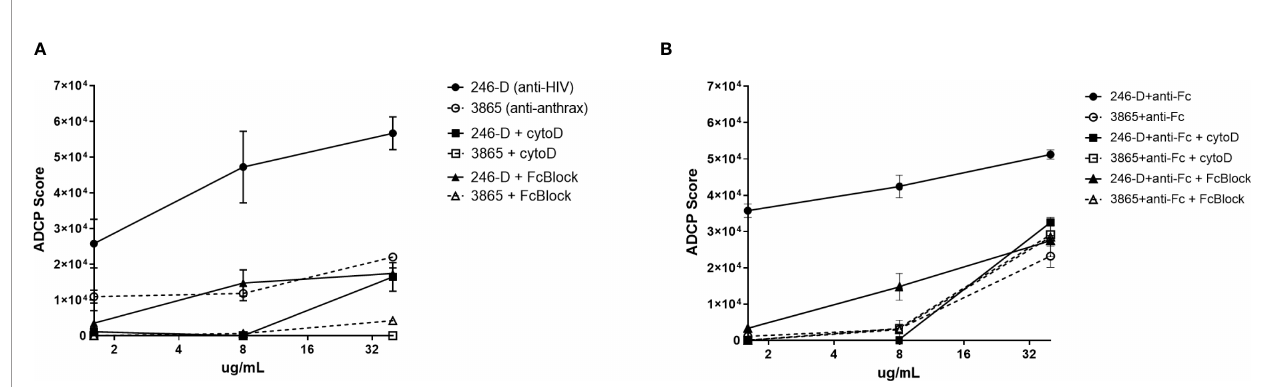
FIGURE 3 | ADCP activity measured using milk phagocytes is actin and FcR dependent. 300ng/mL GFP-HIV per well was incubated with titrated IgG1 mAb for 2hrs at 37°C. Meanwhile, 50,000 milk cells per well in a separate plate were prepared, with certain wells pre-incubated with 10ug/mL of the actin inhibitor Cytochalasin-D (Sigma) or 50ug/mL of FcR blocking agent FcBlock (BD) for 30min at 37°C. (A) Virus ADCP; (B) Immune complex ADCP: 100ug/mL anti-human IgG(Fc) was added to virus-Ab complexes and incubated for 30 min at 37°C prior to the addition of cells. Plated cells were washed and incubated with virus/mAb complexes. Plates were washed and incubated in Accutase cell detachment solution, then washed and stained. ADCP activity was measured as the percent of GFP+ cells, with ADCP scores calculated as [(MFI of GFP-positive cells) x (% of GFP+ cells of CD45+ population)]. Data shown was measured for CD45+ population. Mean values of duplicate experiments are shown with